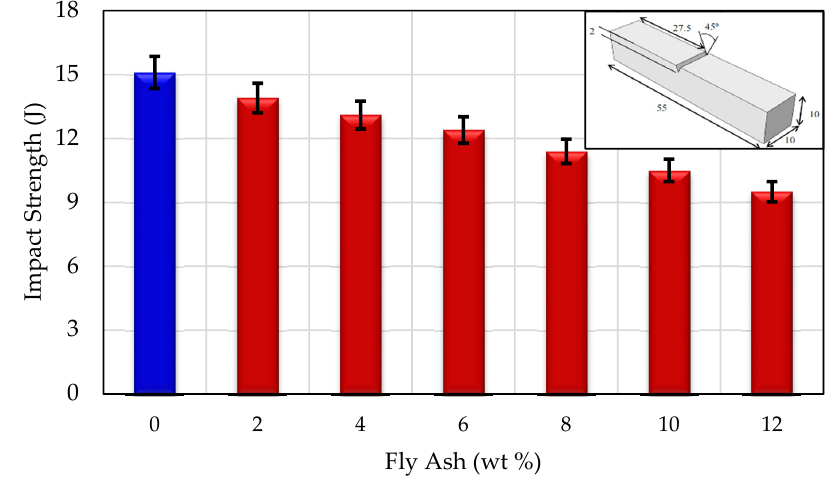
Figure 9. Charpy impact energy of AA6063-FA composites as a function of fly ash percentage content (All dimensions in mm).